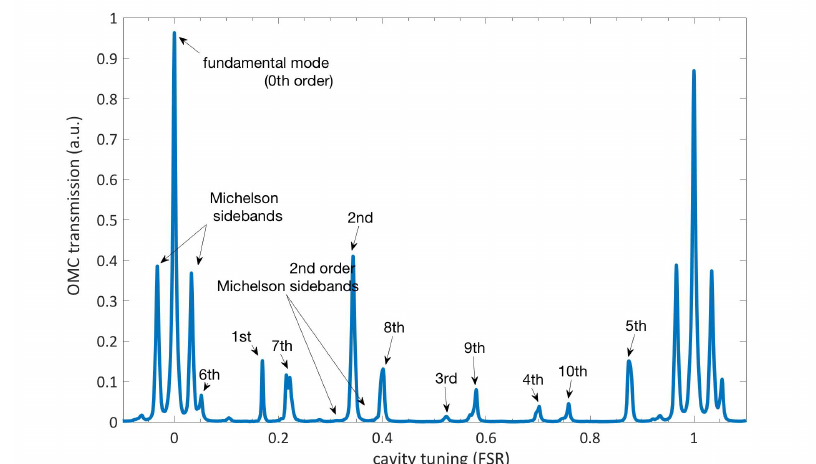
Figure 1. A mode scan of the output mode cleaner (OMC) with dark fringe offset (DFO) (Figure taken from [3]) showing the higher order transversal mode (HOM) content of the interferometer (IFO) output